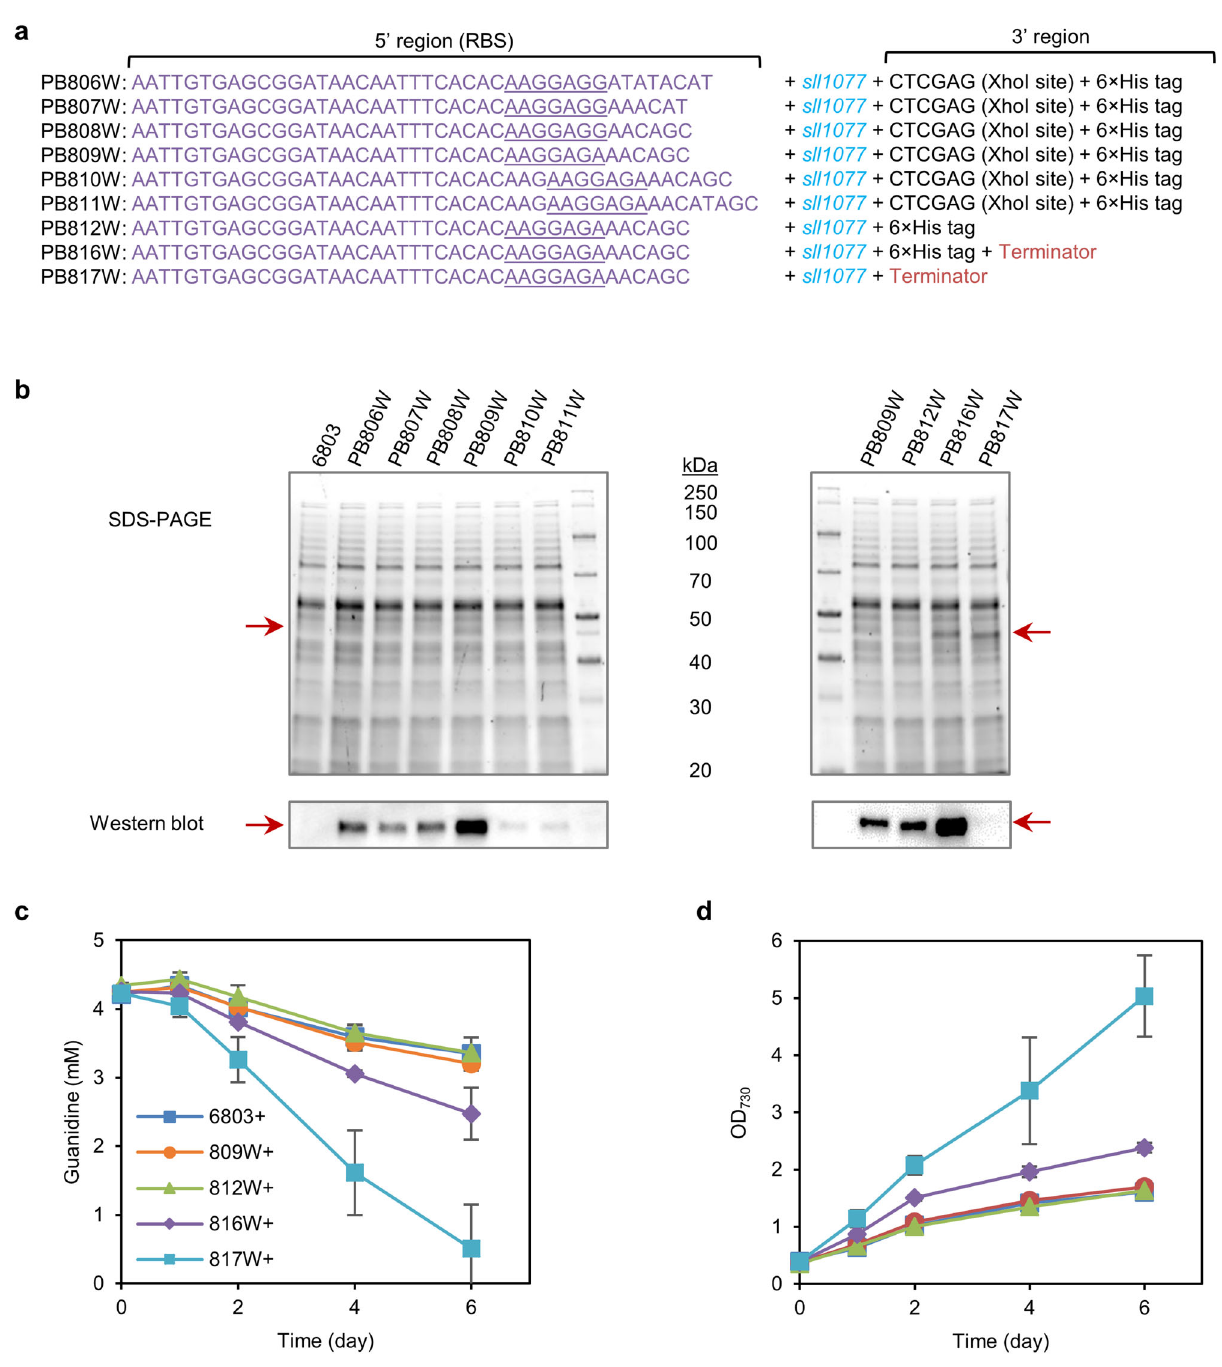
Fig. 3 Overexpression of Sll1077 accelerates guanidine degradation and promotes biomass growth in Synechocystis 6803. a Strategies for enhancing the overexpression of gene sll1077 in Synechocystis 6803. Gene sll1077 was overexpressed driven by the tac promoter, with its RBS (purple nucleotides, including the entire 5 ’ -untranslated sequence upstream of the start codon of gene sll1077 ) at the 5 ’ -region and the His tag and terminator at the 3 ’ -region optimized. b SDS-PAGE and western blotting (His tag) showing the improved expression of Sll1077 in Synechocystis . Representative data from two independent experiments. c Guanidine-degradation pro fi les of Synechocystis 6803 and sll1077 -overexpressing strains. d Cell growth curves for Synechocystis 6803 and sll1077 -overexpressing strains, indicated by readings of OD 730 of cell cultures. Data represent means and standard deviations from three biological replicates. Source data underlying panels ( c , d ) are provided as a Source Data fi